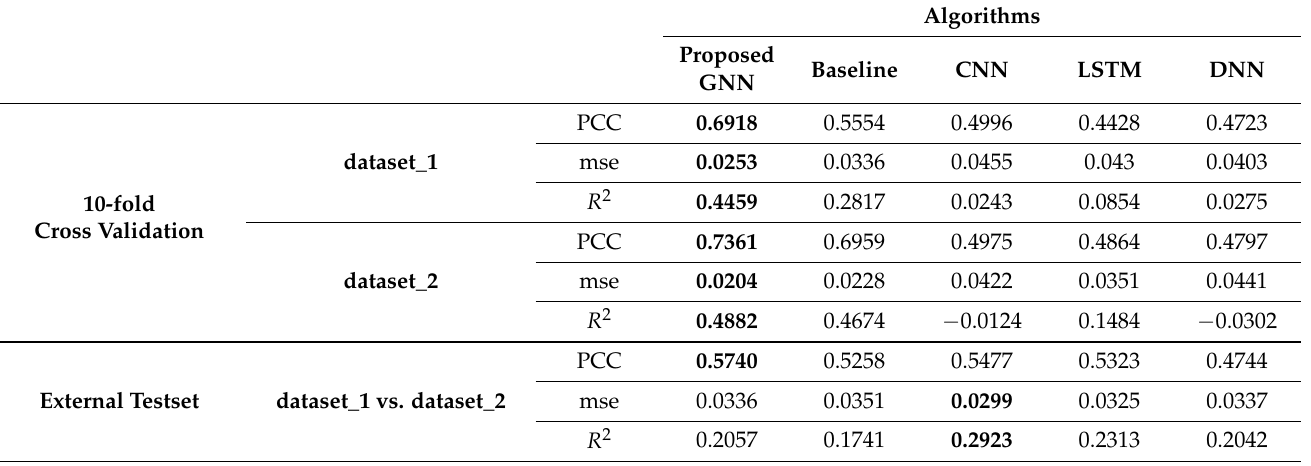
Table 2. Comparison of the proposed GNN approach against the other four models in terms of PCC, mse, and R 2 . Both 10-fold cross validation and external testing are reported. Bold values indicate best